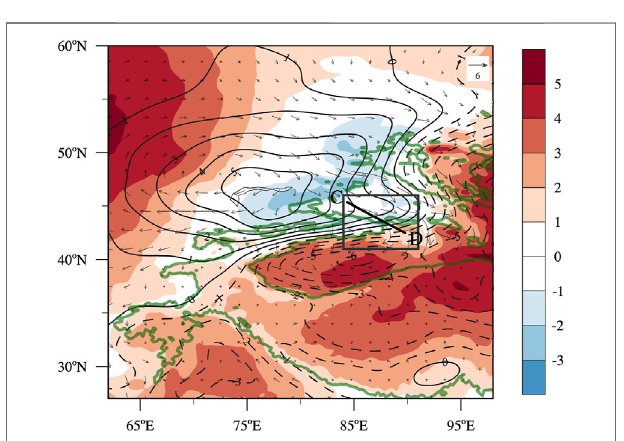
FIGURE 11 | Differences between the composite pressure (contour, unit: hPa), temperature (shading, unit: K), and horizontal wind fi elds (vector) at the surface in the two cases of Low_Wind and High_Wind (High_Wind minus Low_Wind). The green isoline denotes the elevation of 3,000 m, while the black box indicates the location of the Tianshan Grand Canyon (TGC).